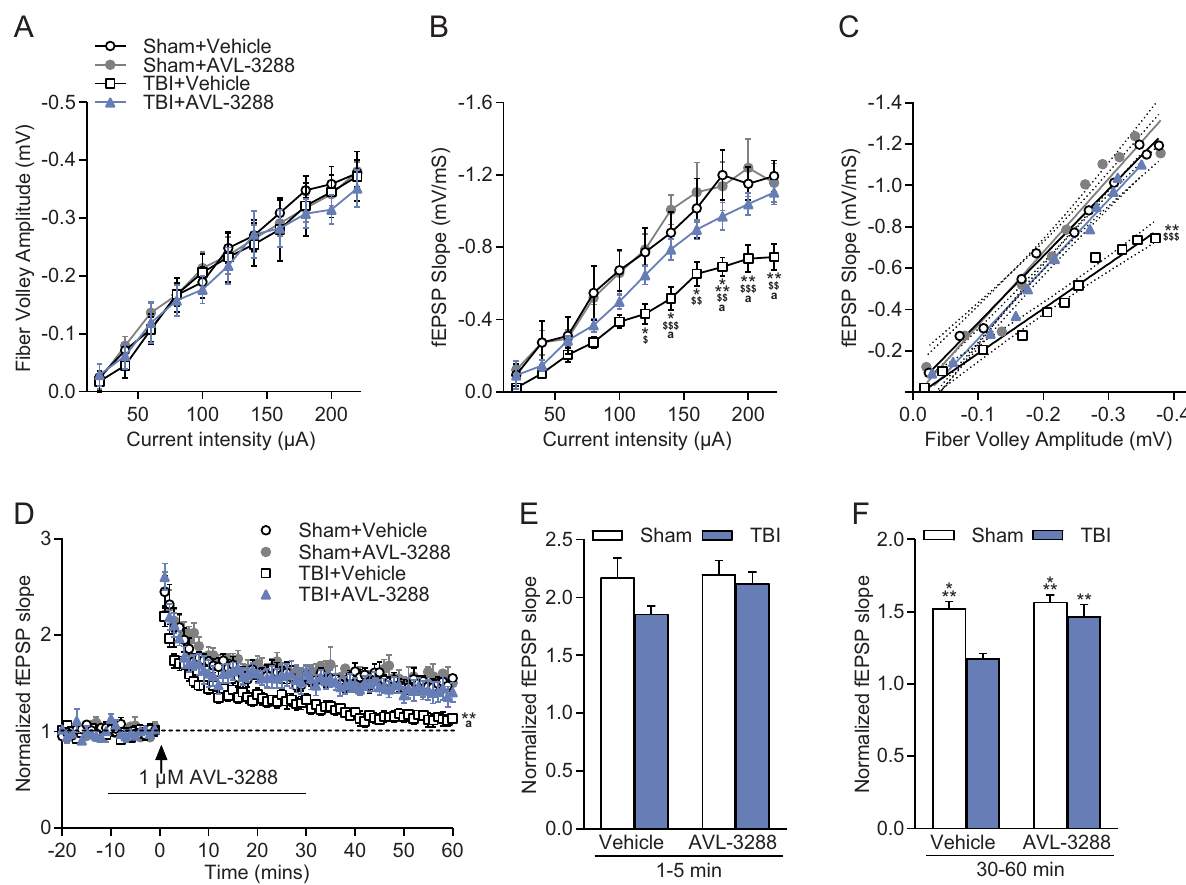
Fig 5. Electrophysiology. Improvement of basal synaptic transmission and rescue of hippocampal LTP with AVL-3288 treatment. A) I-O curves in stratum radiatum of area CA1 of the fiber volley amplitude and stimulus intensity. B) I-O curves of the fEPSP slope and stimulus intensity. � p < 0.05, �� p < 0.01, ��� p < 0.001 vs. Sham+Vehicle, a p < 0.05 vs. TBI+AVL-3288, $ p < 0.05, $$ p < 0.01, $$$ p < 0.001 vs. Sham+AVL-3288, repeated measures two-way ANOVA with Tukey’s HSD post-hoc test. C) I-O curves of the fiber volley amplitude and fEPSP slope relationship. Dotted lines depict 95% confidence intervals. �� p < 0.01 vs. Sham+Vehicle, TBI+AVL-3288, $$ $ p < 0.001 vs. Sham+AVL-3228, two-way ANOVA of linear regression fit slopes. D) Hippocampal LTP in area CA1. �� p < 0.01 vs. Sham+Vehicle, Sham+AVL-3288, a p < 0.05 vs. TBI+AVL-3288, repeated measures two-way ANOVA with Tukey’s HSD post-hoc test. E) Effects of AVL-3288 on the initial phase of LTP, 1–5 min after HFS. F) Effects of AVL-3288 on the maintenance phase of LTP, 30–60 min after HFS. �� p < 0.01, ��� p < 0.001 vs. TBI+Vehicle, two-way ANOVA with Tukey’s HSD post-hoc test. Mean ± SEM, n = 5 slices/5 Sham +Vehicle animals, n = 5 slices/5 Sham+AVL-3288 animals, n = 7 slices/6 TBI+Vehicle animals, n = 7–8 slices/7 TBI+AVL-3288 animals.